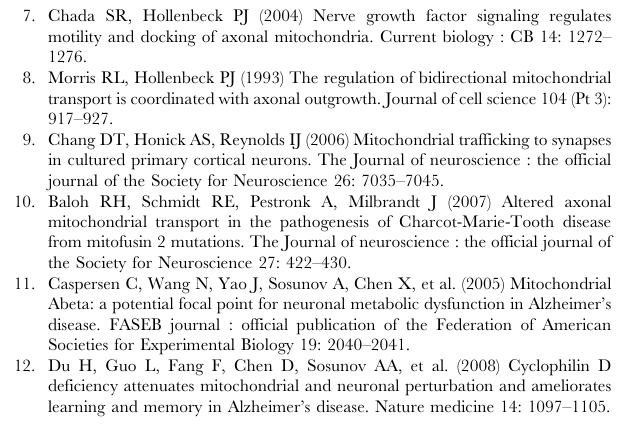
Figure S4 Effect of CypD depletion on A23187-induced intra- axonal calcium elevation. NonTg and Ppif 2 / 2 hippocampal neurons were exposed to A23187 (5 m M for 30 min) and subjected to recording of intra-axonal calcium before and after A23187 treatment. A23187 treatment resulted in increased axonal calcium level in nonTg neurons. Ppif 2 / 2 neurons abolished A23187- induced calcium elevation.